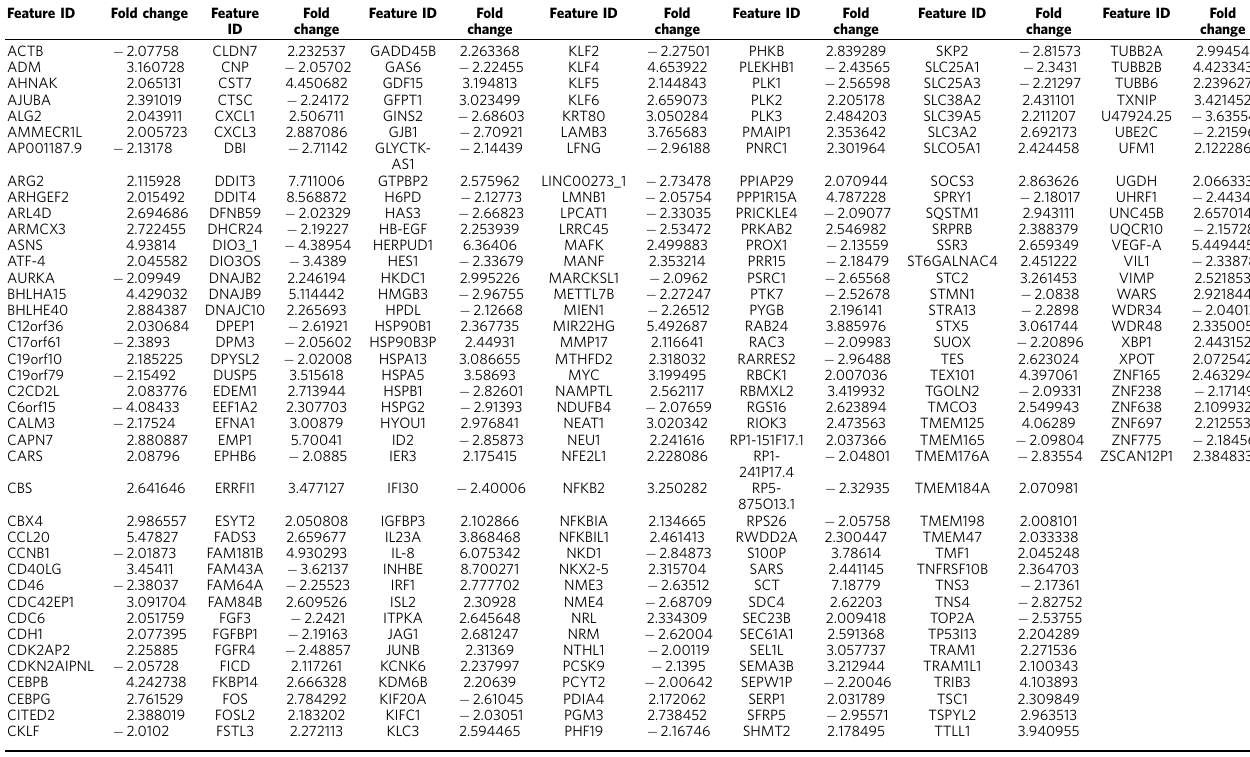
Table 2 | The mRNAs selected by a high-throughput sequencing analysis. Feature